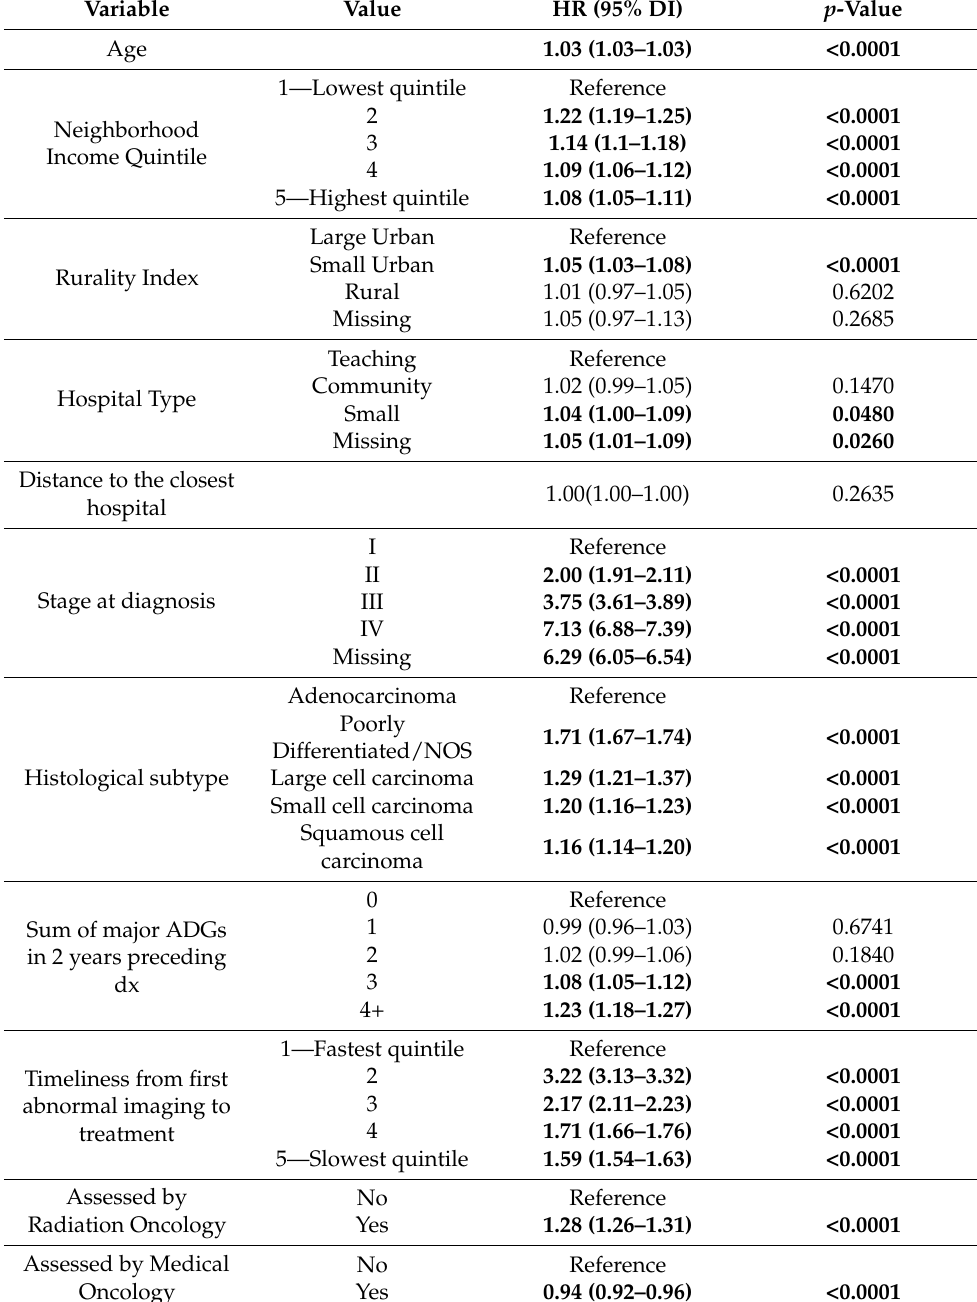
Table 4. Multivariable Cox modeling demonstrating the impact of patient, disease, and system characteristics on cancer-specific mortality for all LC patients in